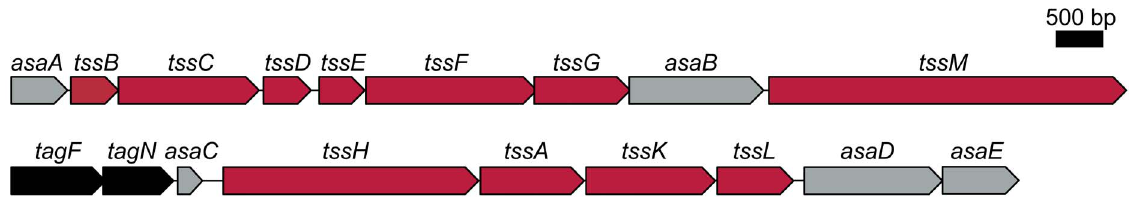
Figure 1. The predicted T6SS gene cluster of A.baumannii strain M2. A single , 23 kb gene cluster, asaA-tssBC-hcp-tssEFG-asaB-tssM-tagFN- asaC-tssHAKL-asaDE carries 18 putative genes predicted to encode for components of a T6SS. The genome of A. baumannii strain M2 carries genes that are predicted to encode 12 of the 13 core T6SS proteins ( tss, colored scarlet ) , 2 proteins with homology to T6SS-associated proteins in other bacteria ( tag , colored black ) and 5 proteins encoded by genes only identified in A. baumannii T6SS gene clusters ( asa , Acinetobacter type six secretion system-associated, colored gray). Three additional genes whose products have homology to VgrG were identified in other regions of the genome (data not shown).